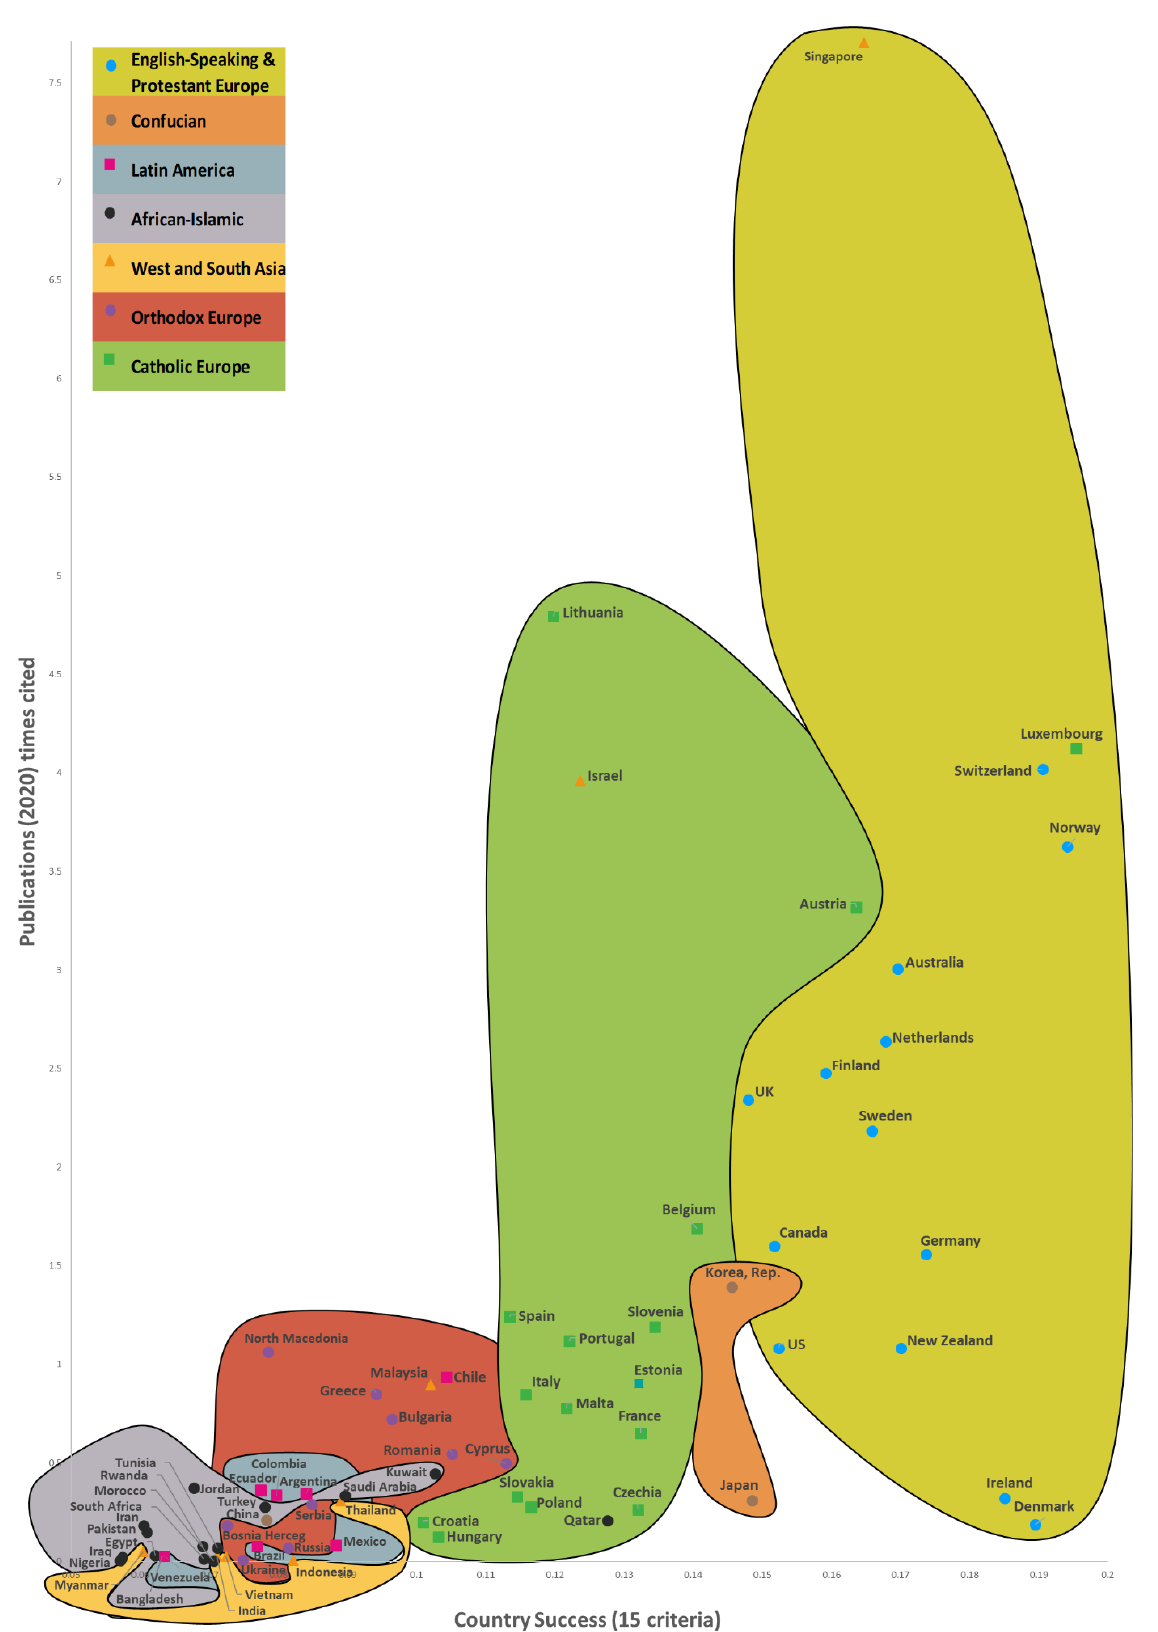
Figure 13. CSP map showing the success of countries in terms of the number of citations of their publications on AFFECT recognition (CSPC) in Web of Science journals with impact factor.